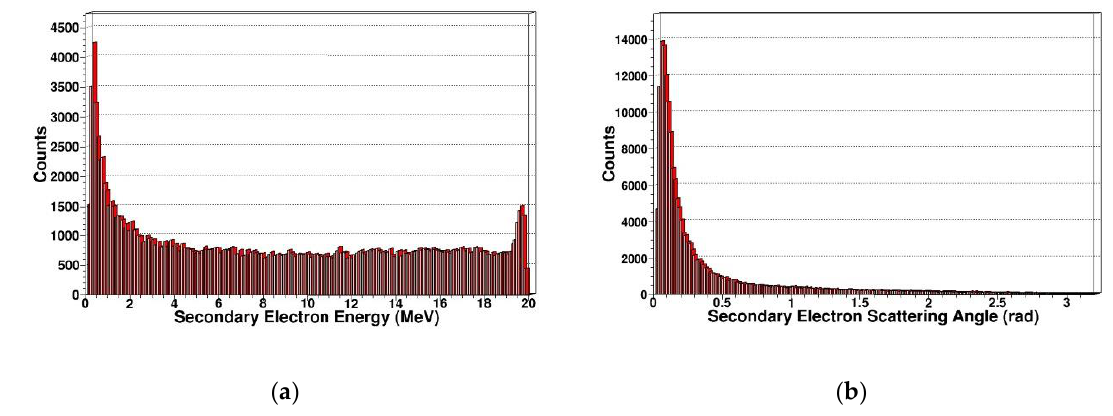
Figure 18. Secondary electrons in SDD generated by 20 MeV gammas: ( a ) Energy spectrum of secondary electrons; ( b ) scattering angle distribution of secondary electrons.